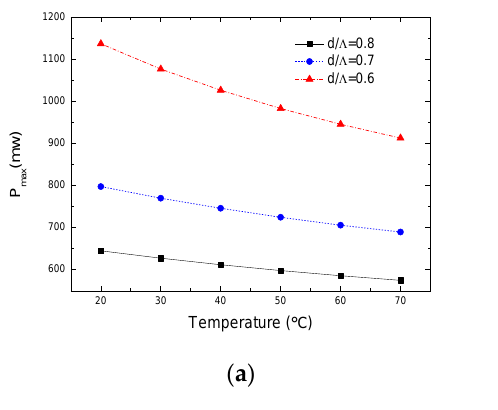
PCF ， and for the same reason, the SBS occurs easily due to the shrinking of the effective mode field